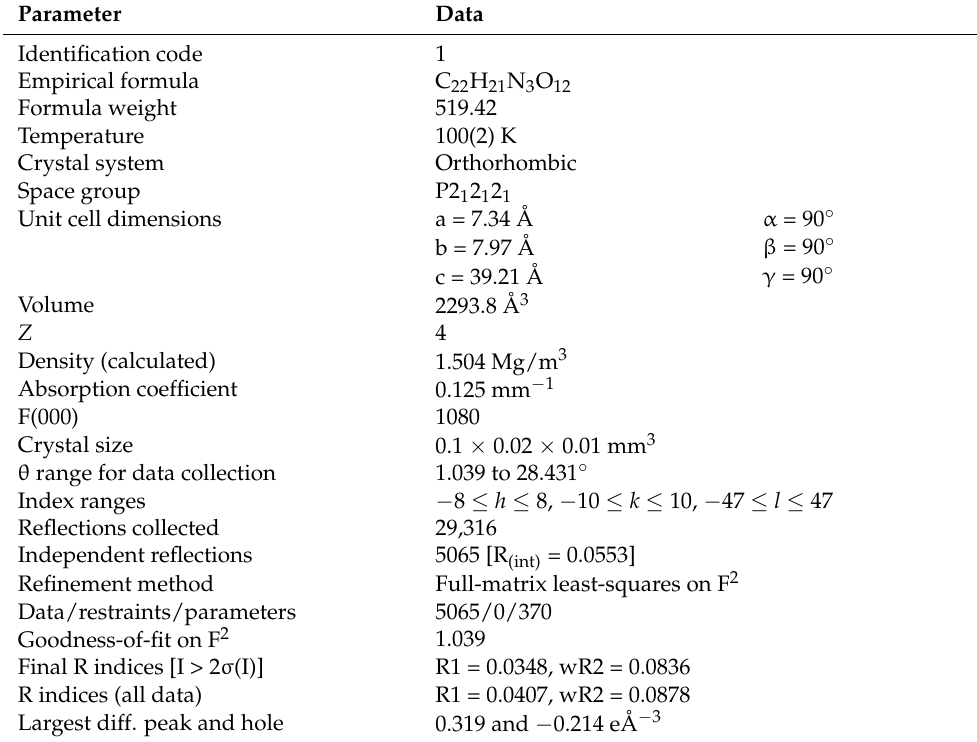
Table 3. Summary of the crystallographic data and refinement statistics for 1